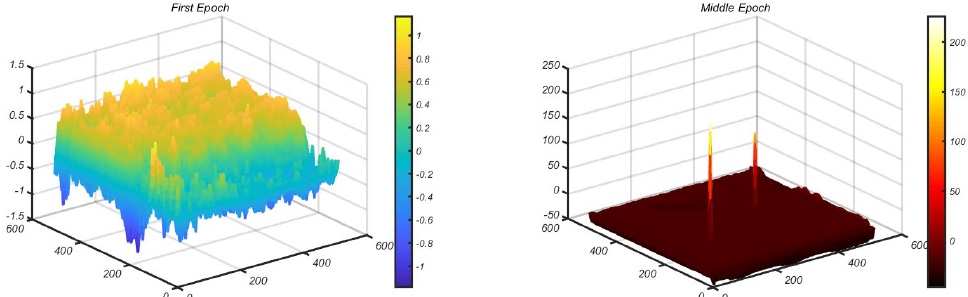
Figure 6. The output x of the network at the first and middle epoch of the training On the other hand, during the training, the value of the loss function varies with the change of the segmentation mask. To ensure smooth training, large changes in the value need to be avoided. In the softIoU loss, a smaller target pixel area (denominator) leads to a larger change in the loss function values corresponding to the same prediction change (change of the numerator), further leading to a drastic gradient change. Once it enters the saturation zone in the early stage of training, it will make the network difficult to